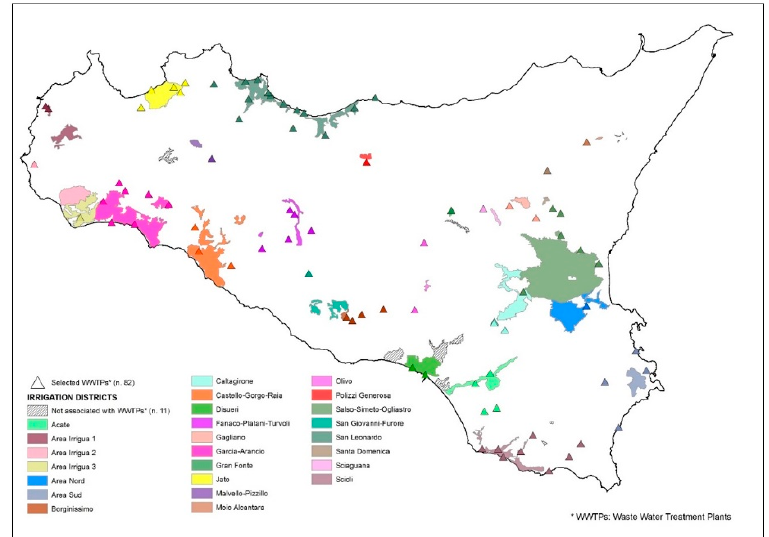
Figure 4. Irrigation districts and the corresponding WWTPs. Same colours indicate WWTP and the irrigation district associated with.